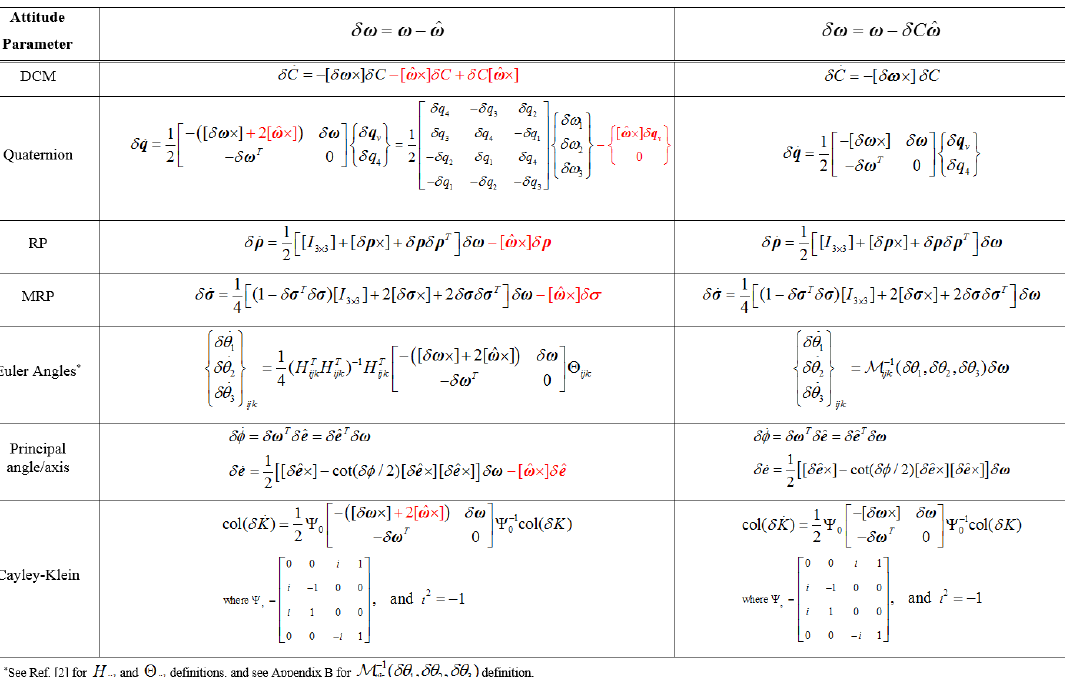
Figure A1. Summary of the attitude error kinematics equations. The terms in red indicate the differences between the two